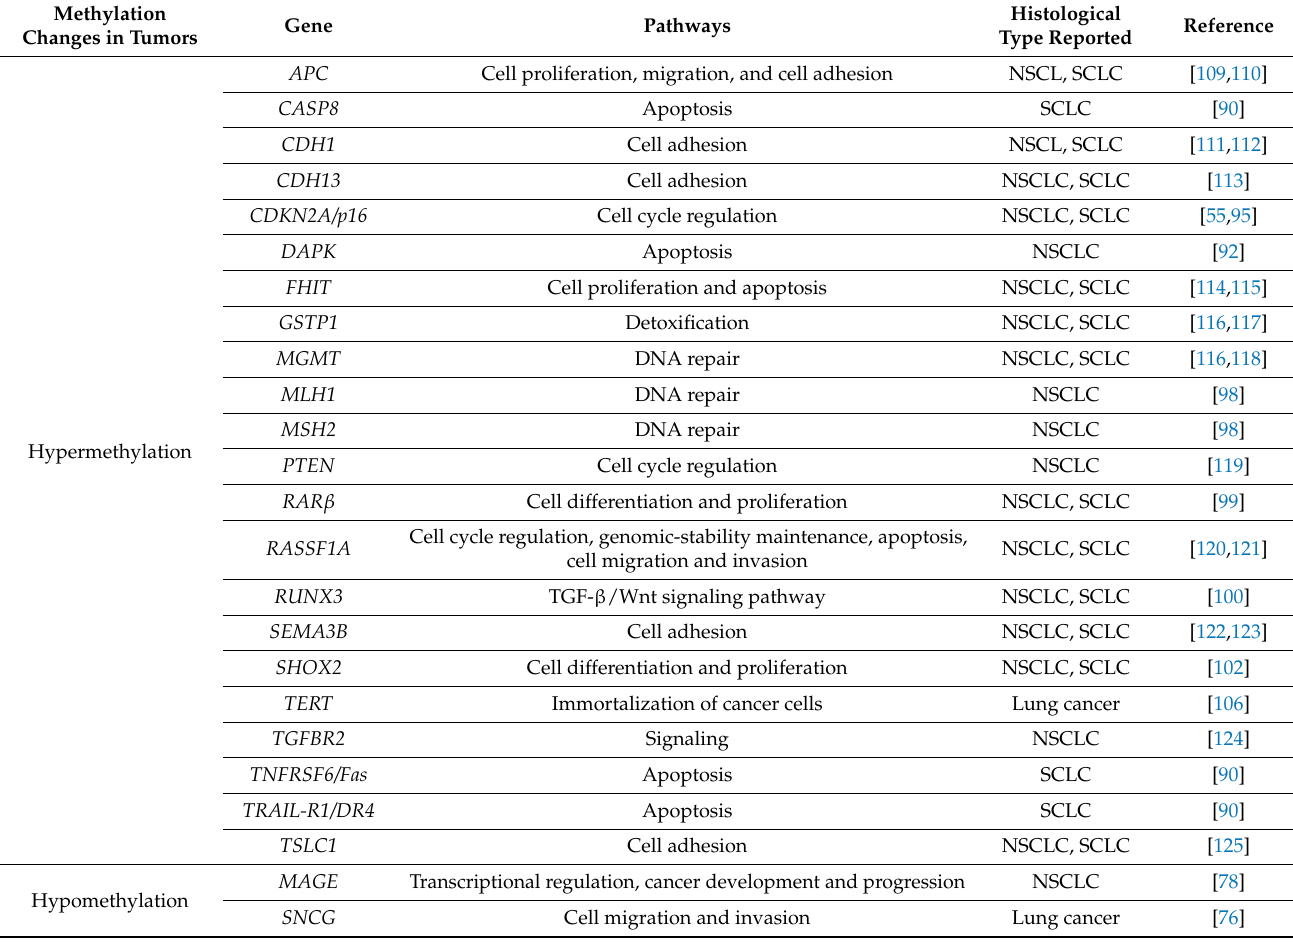
Table 1. Selected list of genes with frequently altered methylation in lung cancer and their biological functions. NSCLC: non-small cell lung cancer; SCLC: small cell lung cancer. Methylation Changes in